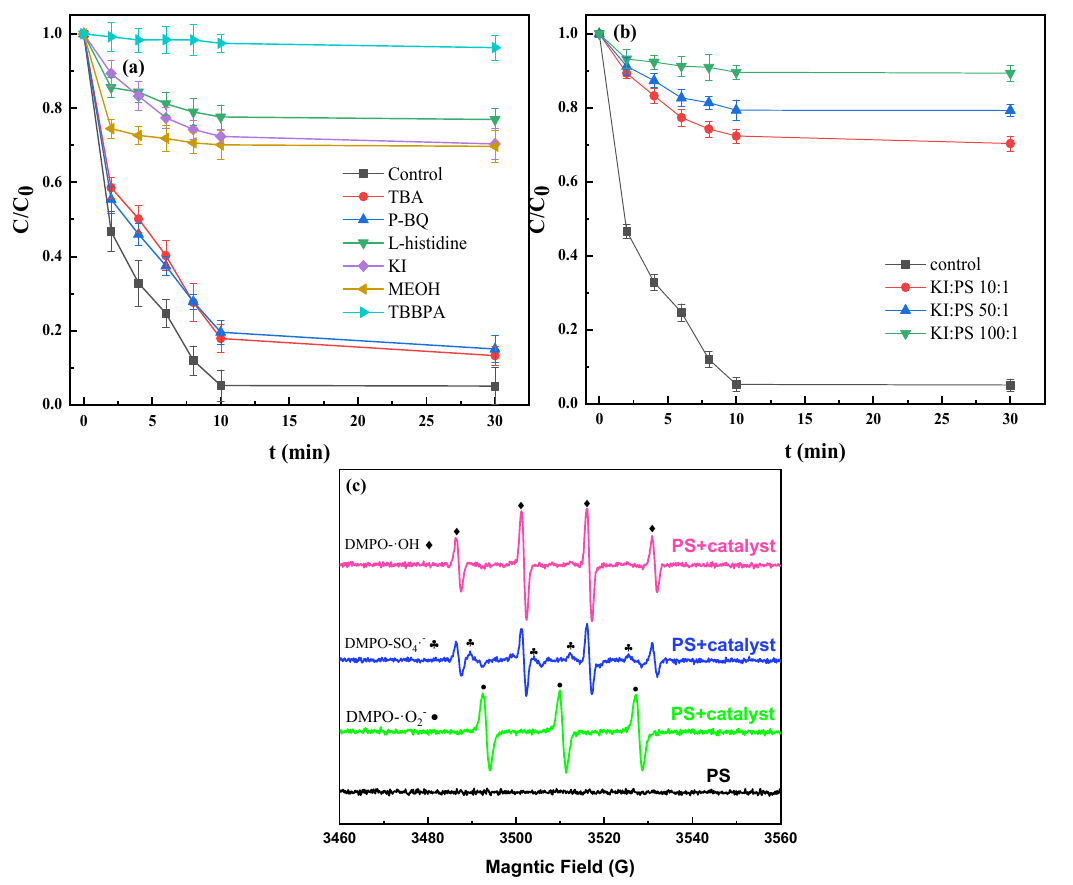
Figure 5. The effect of different quenchers ( a ) and concentrations of KI ( b ) on the performance of Fe@MC/PS system for removing TBBPA and ESR spectrum of reactive oxidative species (ROS) (using DMPO for SO 4 − , OH, TEMP for O 2 − ) ( c ).